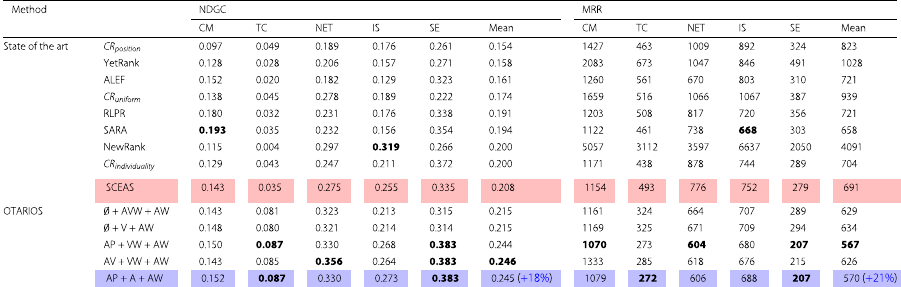
Table 7 Comparison of state of the art (STOA) methods against OTARIOS over all networks